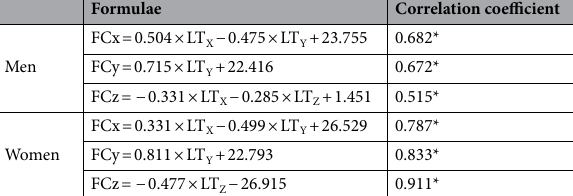
Table 3. The formulae calculated with the multiple regression analysis. * p <